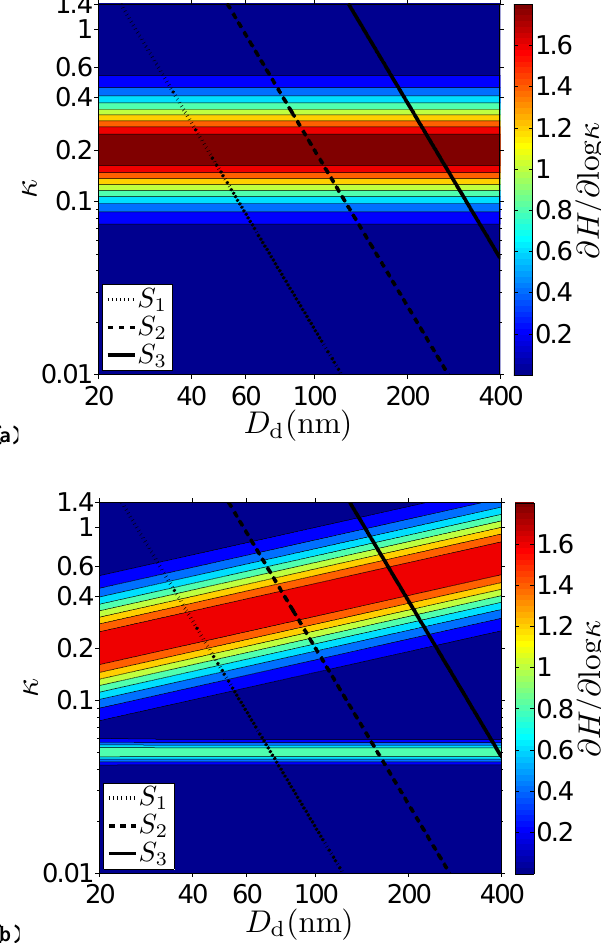
Fig. 4. Logarithmic probability distributions of particle hygroscop- icity, h 10 (κ,D d ) = ∂H(κ,D d )/∂ log κ , plotted over effective hygro- scopicity parameter ( κ ) and dry particle diameter ( D d ) for model aerosols of Case B (a) and of Case C (b) . The tilted black lines in- dicate D d scans at fixed supersaturations ( S 1 = 0.86%, S 2 = 0.26%, S 3 =